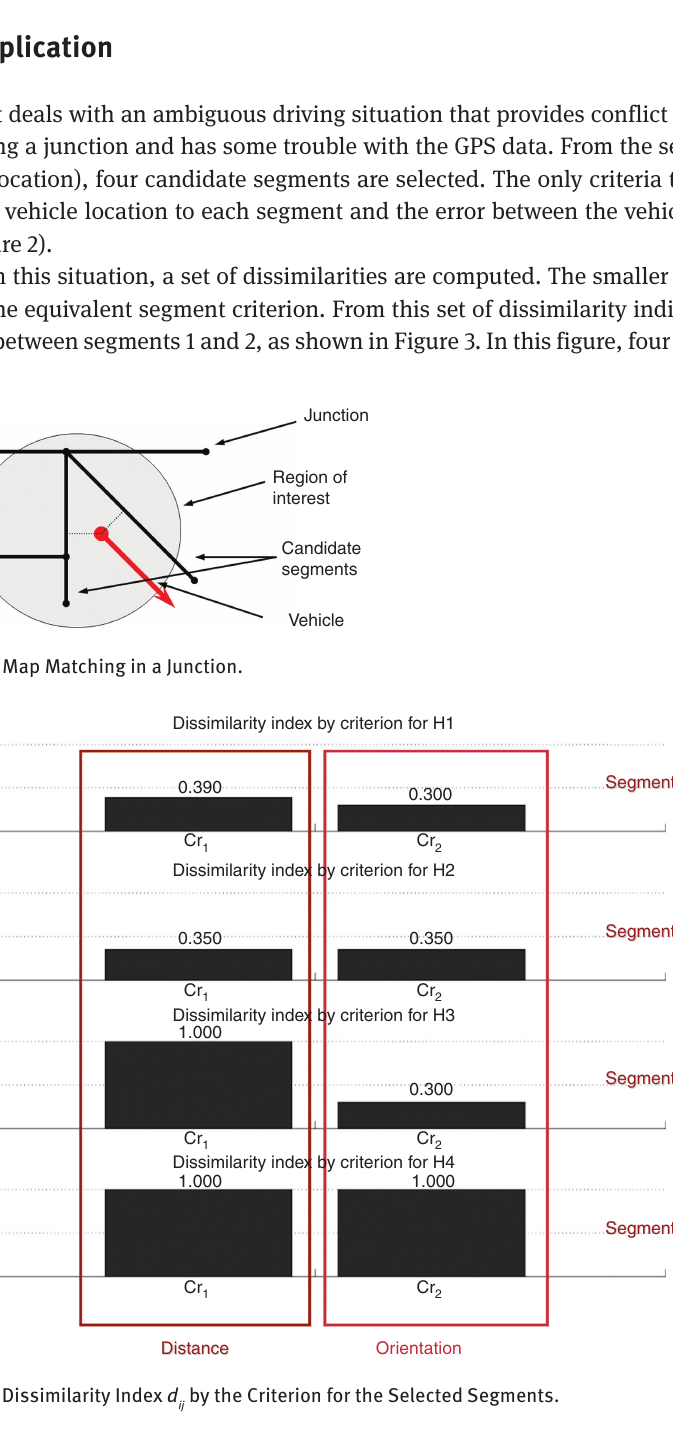
Figure 3. Dissimilarity Index d